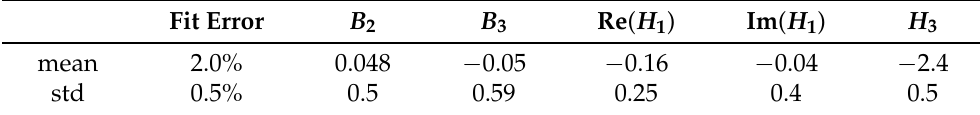
Table 2. Third hypothesis statistics.